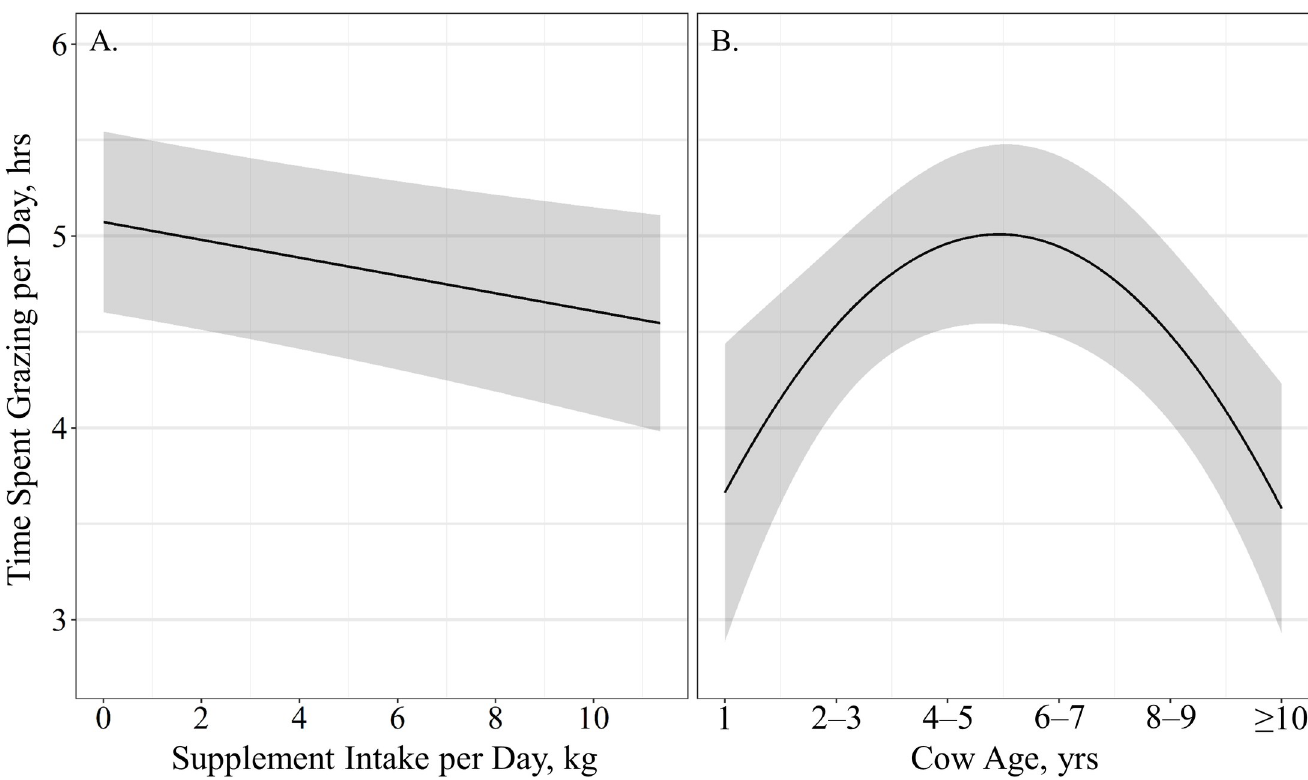
Fig 1. Predicted relationships ( ± 95%CI represented in the shaded area) between ( A ) average supplement intake per day (kg) and ( B ) cow age (years) on time spent grazing per day (hrs) by cattle grazing dormant northern mixed grass rangeland in 2016 – 2017 & 2017 – 2018 at the Northern Agricultural Research Center Thackeray ranch, Havre,